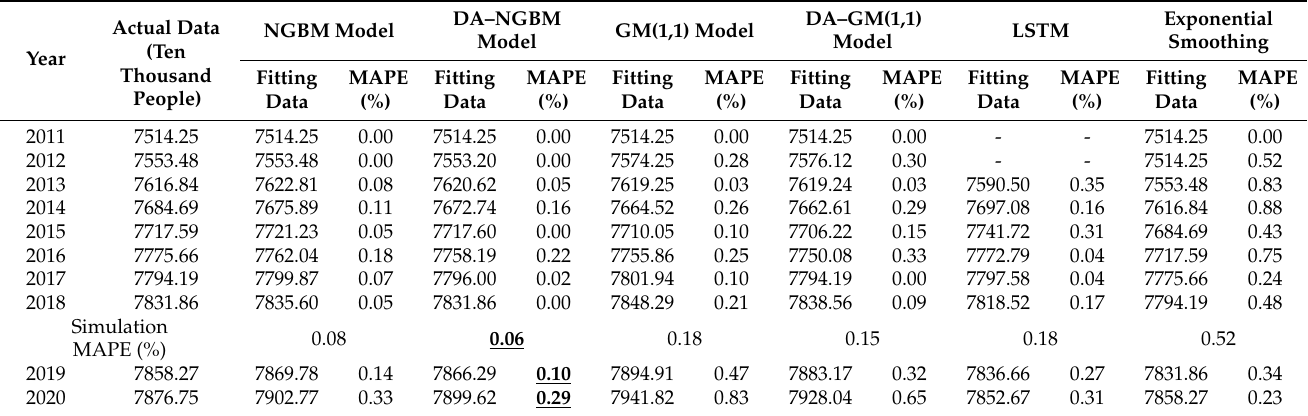
Table 4. Comparison of fitting and predicted values of registered population in Jiangsu